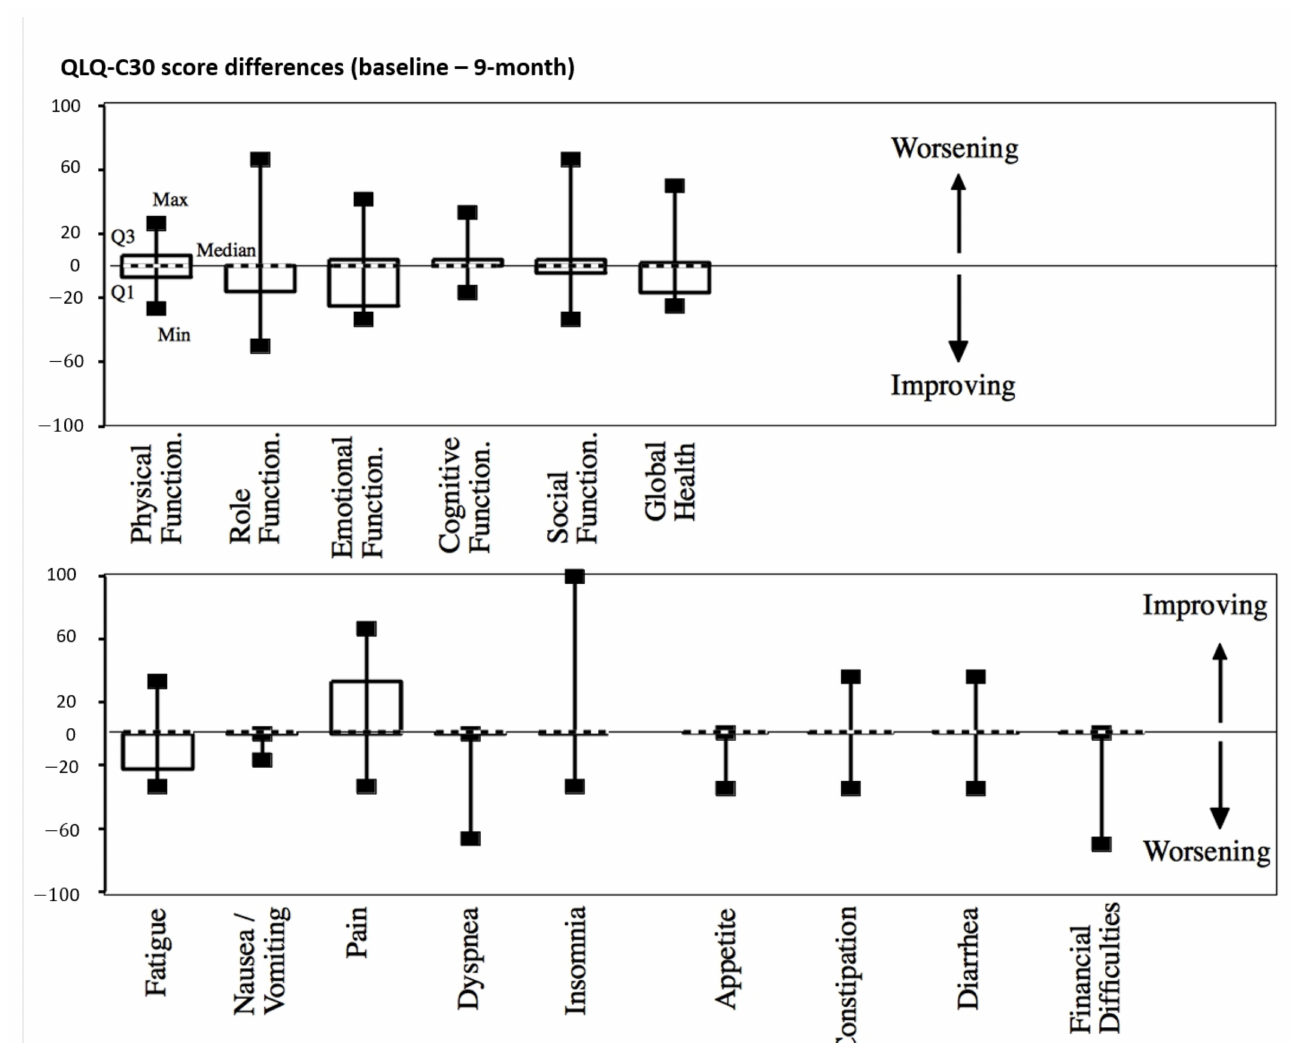
Figure 4. QLQ-C30 score differences between baseline and 9 months after treatment. Median values are shown with dashed